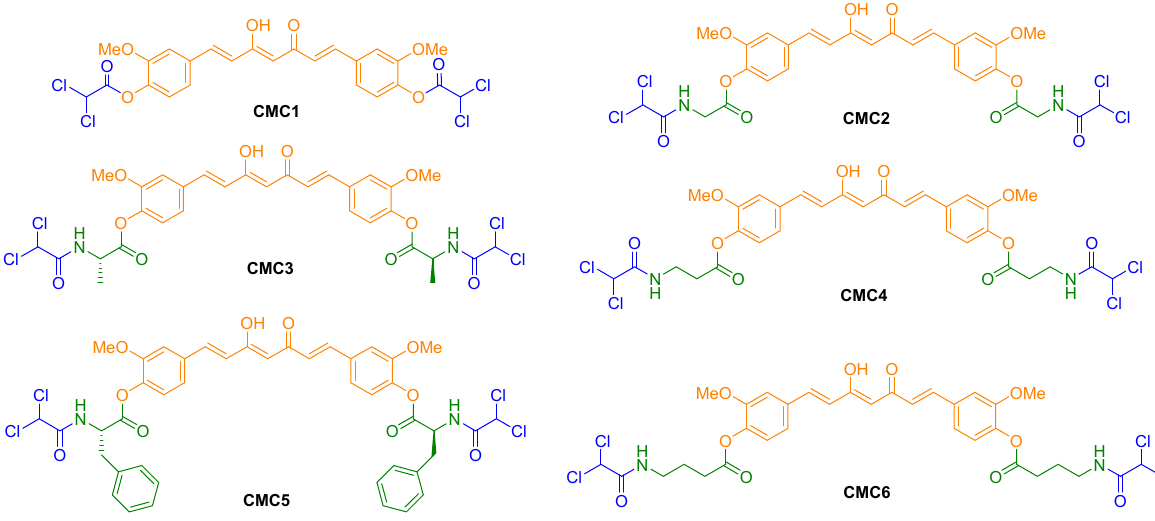
Figure 3. Structures of synthesized CUR and DCA hybrid conjugates CMC1–6.